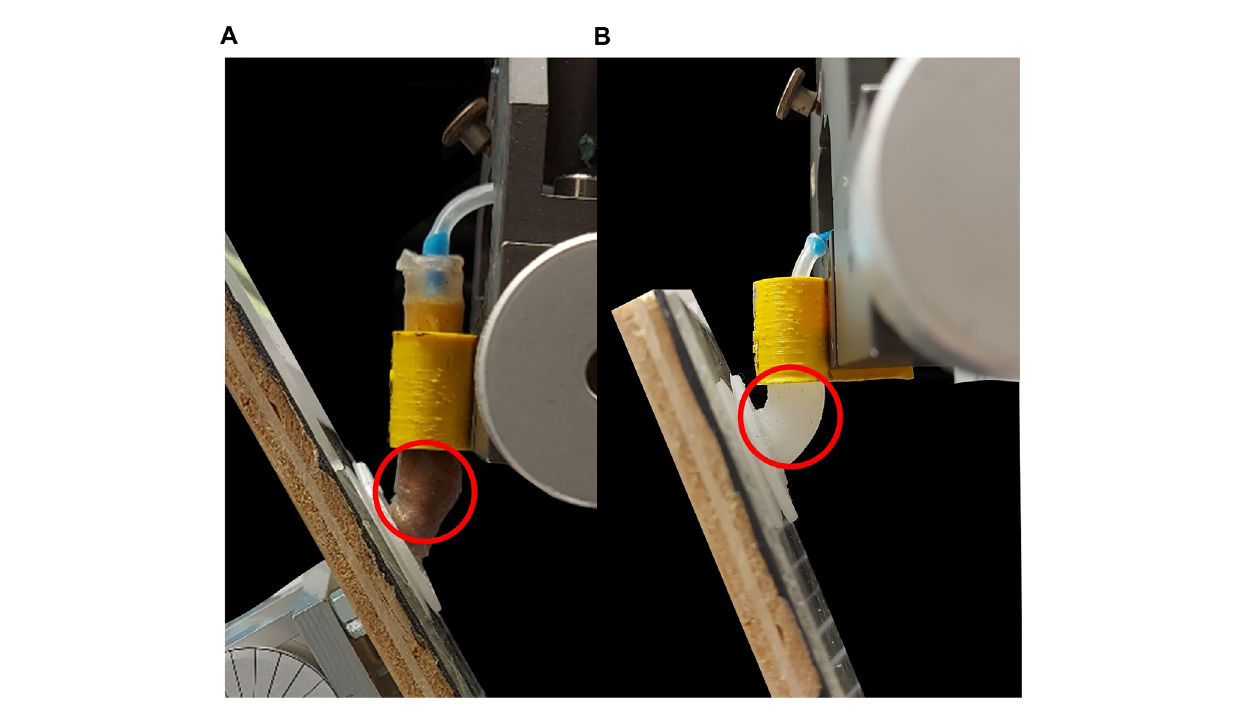
FIGURE 8 The suction cup shape while attached to a steep angle. (A) the wrinkle and hinge-like behavior of the granular stalk (B) the uniform bending curvature in silicone rubber stalk.